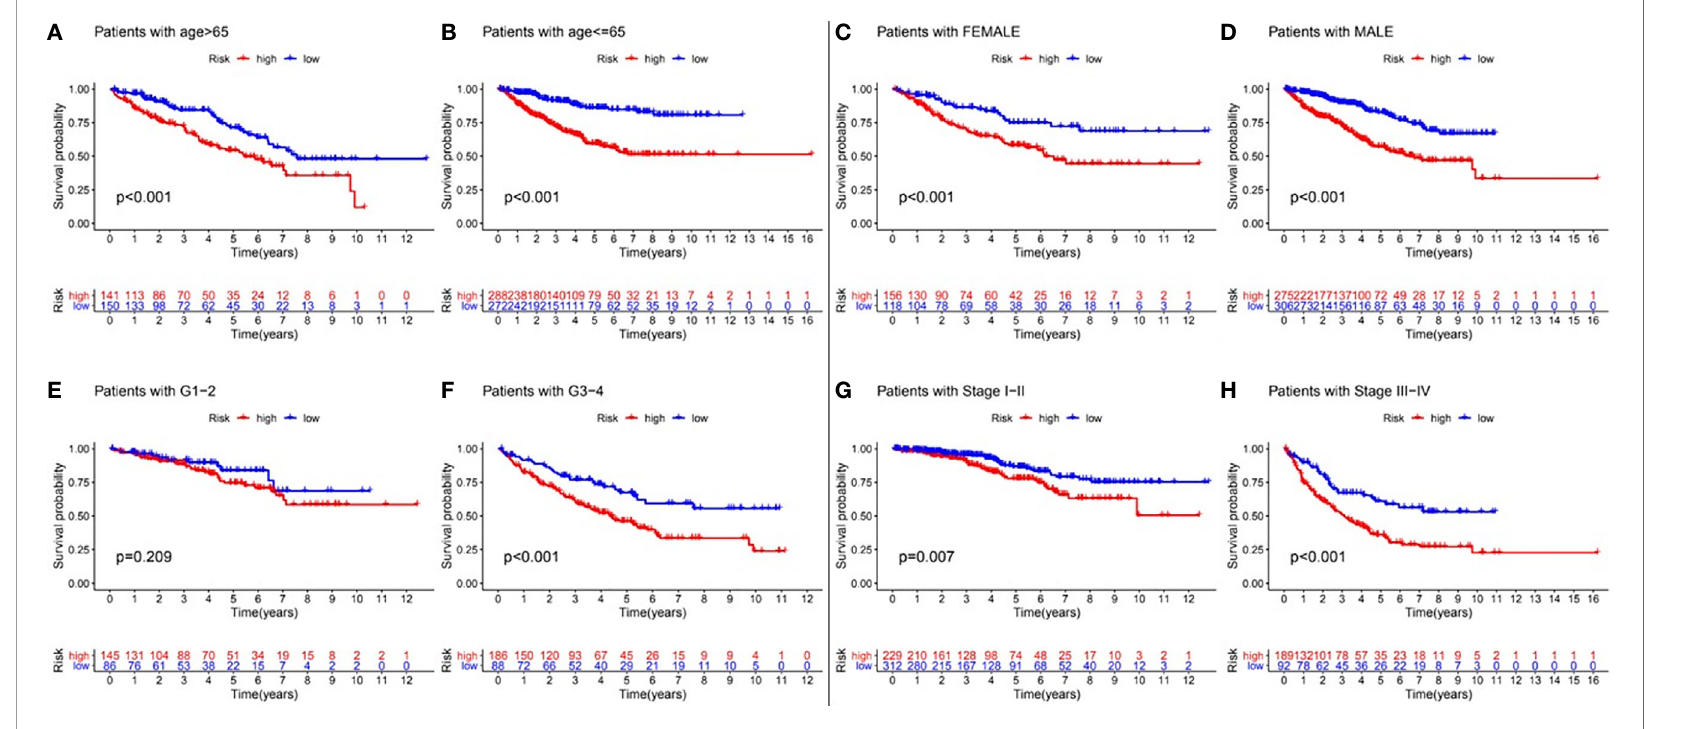
FIGURE 5 | Clinical strati fi cation analysis of the differences in overall survival between the high- and low-risk RCC patients by age, gender, tumor grade and tumor clinical stage. Kaplan-Meier survival curves of patients in high- and low-risk groups within six clinically strati fi ed subgroups, including patients with age>65 years (A) , age<=65 years (B) , the gender of female (C) , the gender of male (D) , the tumor grade of G1-2 (E) , grade of G3-4 (F) , the tumor stage of I-II (G) , and the tumor stage of III-IV (H) , respectively. Log-rank test (p<0.05) showed that patients with a low-risk score had signi fi cantly better survival outcomes than those with a high-risk score in all the subgroups except for the tumor grade G1-2